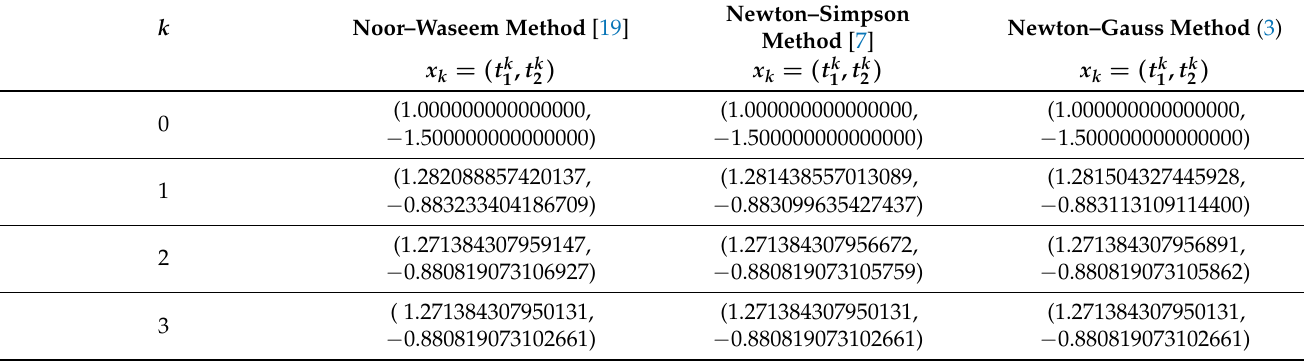
Table 5. Method—Order